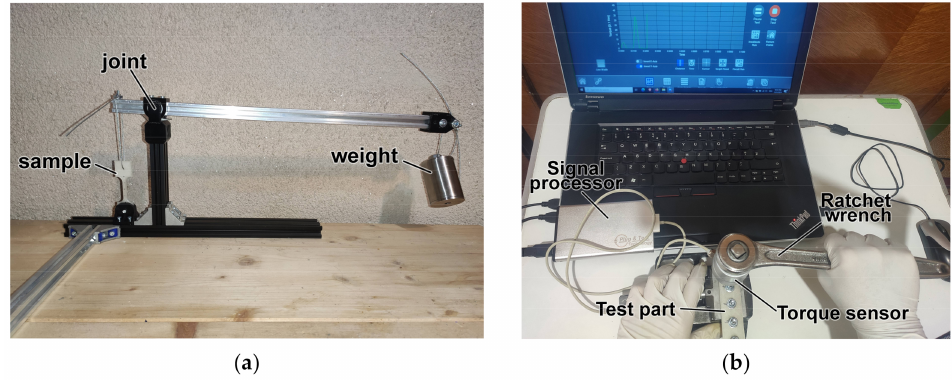
Figure 2. Testing of creep properties: ( a ) tension creep testing rig; ( b ) compression creep testing setup.